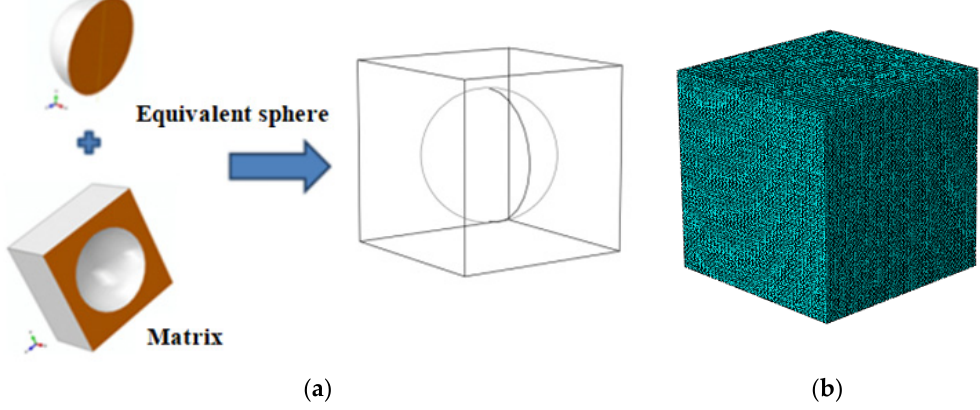
Figure 11. ( a ) The two-phase composite unit cell 2 and ( b ) the related mesh division.